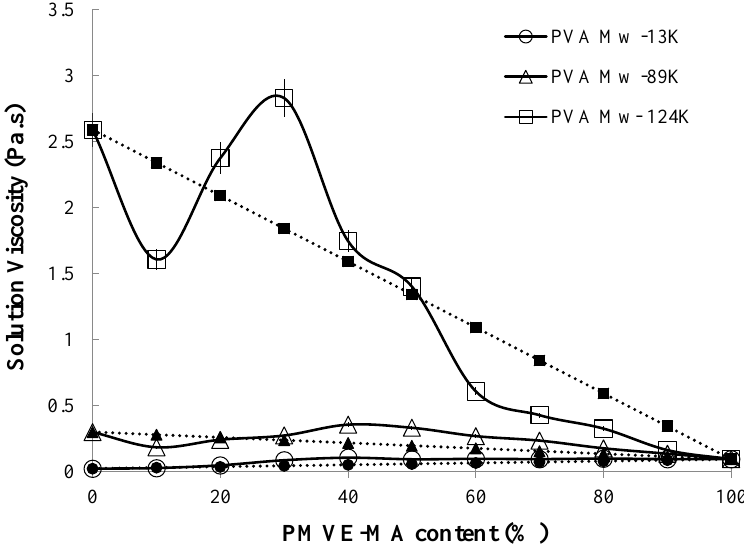
Figure 2. Viscosity of PVA/PMVE-MA blends for different molecular weight PVA as a function of PMVE-MA content by weight, compared to the linear additive viscosity values (dotted lines). Values are means ±